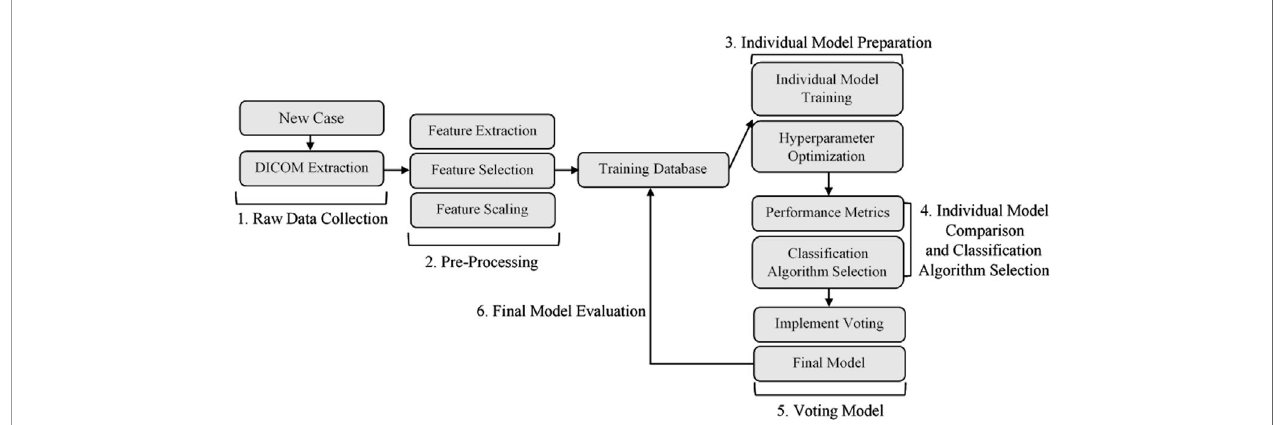
FIGURE 1 | Model development work fl ow. (1) Data collection and DICOM extraction. (2) Data pre-processing and feature engineering. (3) Training and optimization of a set of classi fi cation algorithms for comparison. (4) Selection of subset of trained and optimized individual models. (5) Individual model combination through voting. (6) Evaluation of fi nal ML voting model. DICOM, Digital Imaging and Communications in